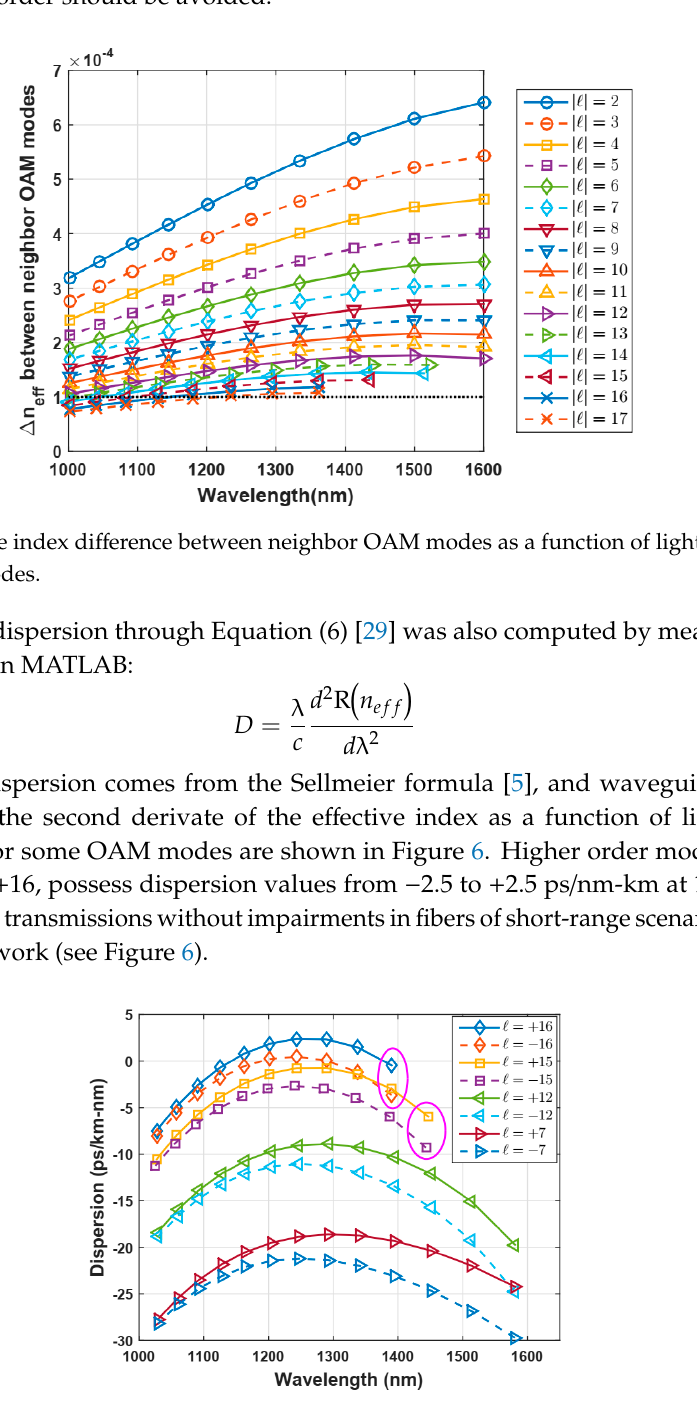
Figure 6. Chromatic dispersion for OAM modes of different topological charges. Circles in magenta indicate the modal cut-off of these OAM modes.